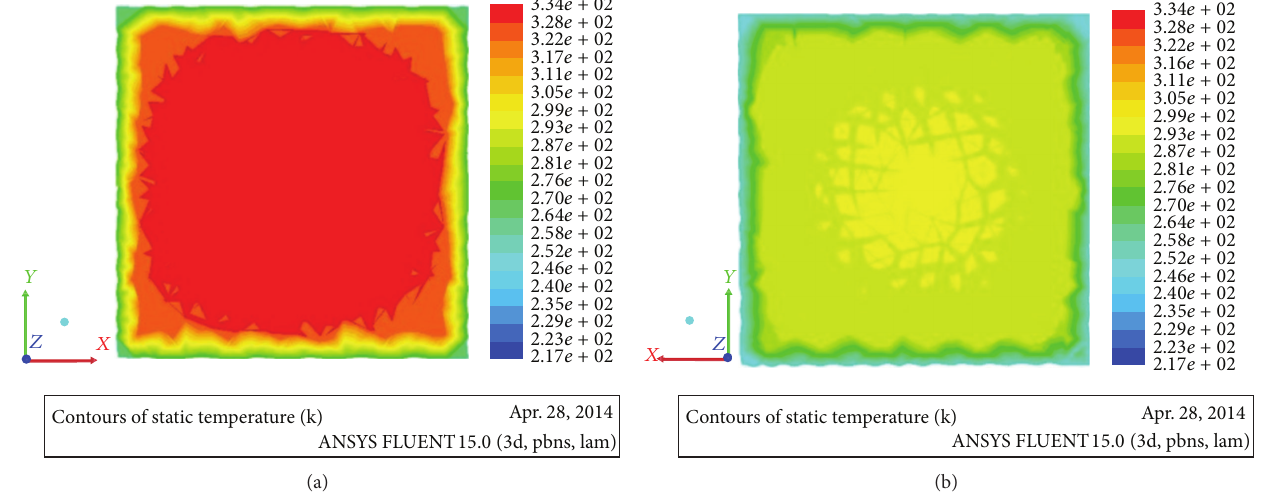
Figure 15: Temperature distribution on upside of the thin film cell and downside of the